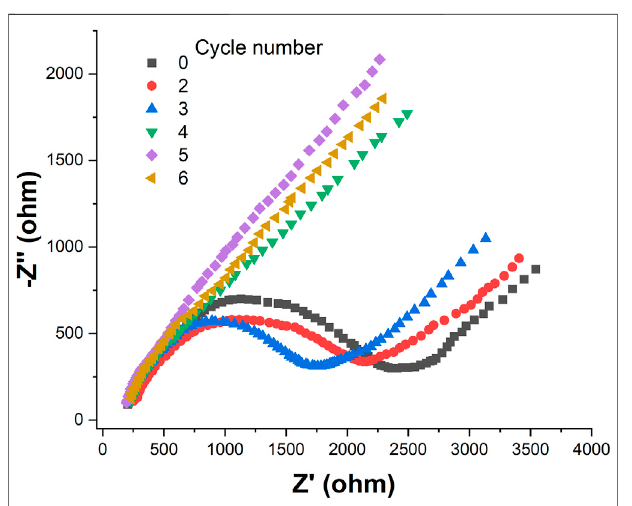
5 mM [Fe(CN) 6 ] 3 − /4 − .